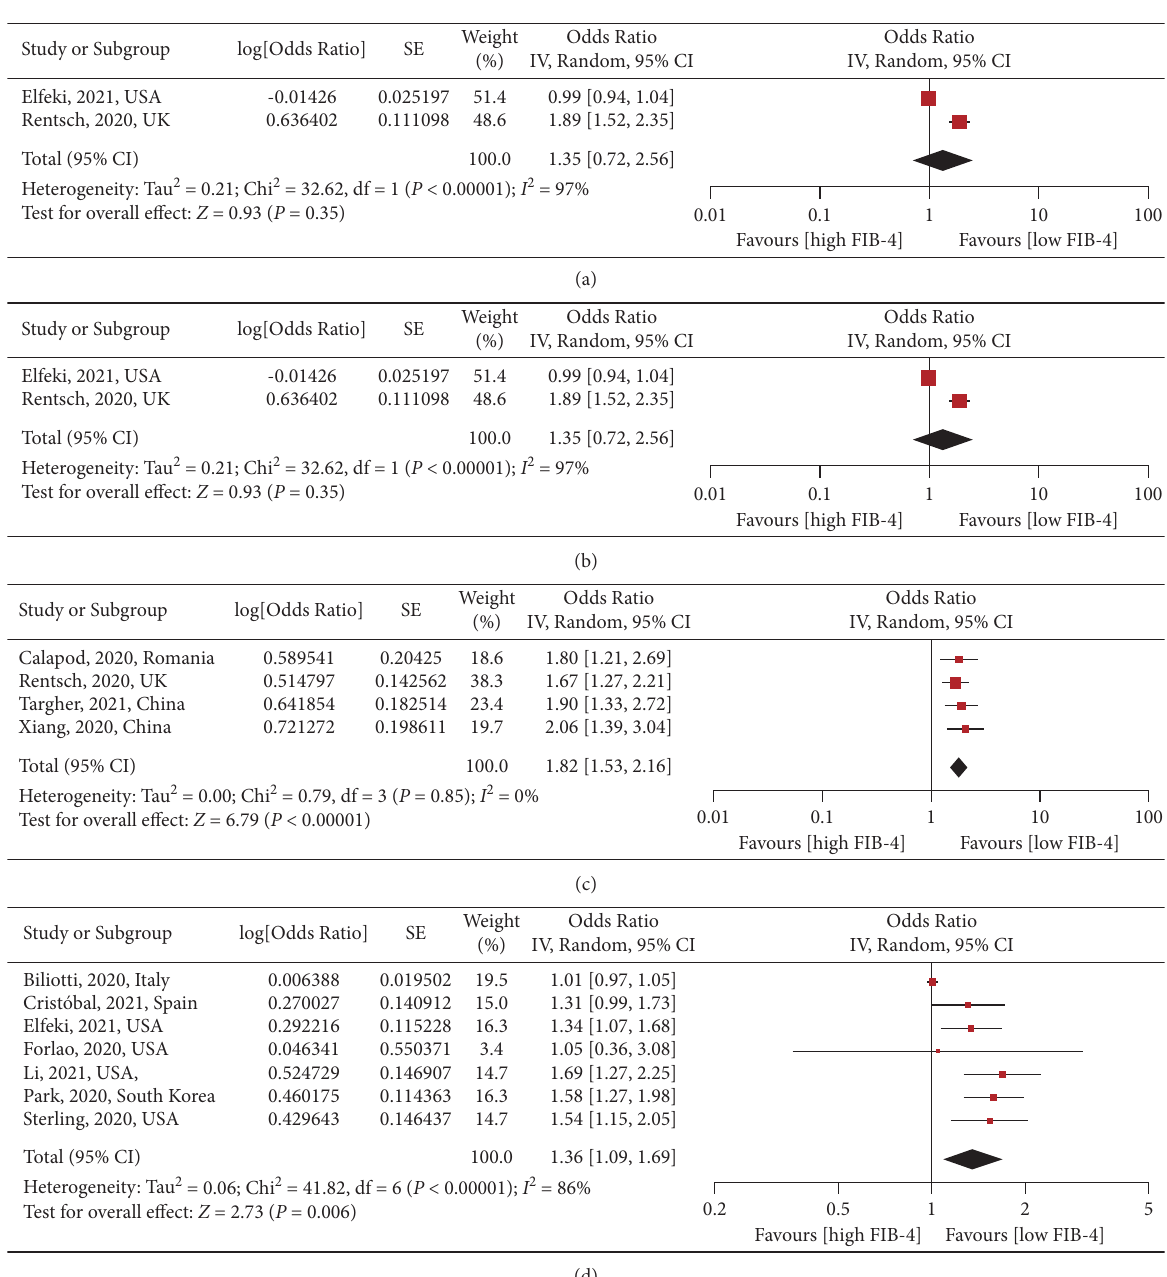
Figure 2: Association between FIB-4 and clinical outcomes in patients with COVID-19. FIB-4 was analyzed for continuous analysis (per one-point increase). (a) Hospitalization. (b) MV. (c) Severe COVID-19. (d) Death. Abbreviation: MV, mechanical